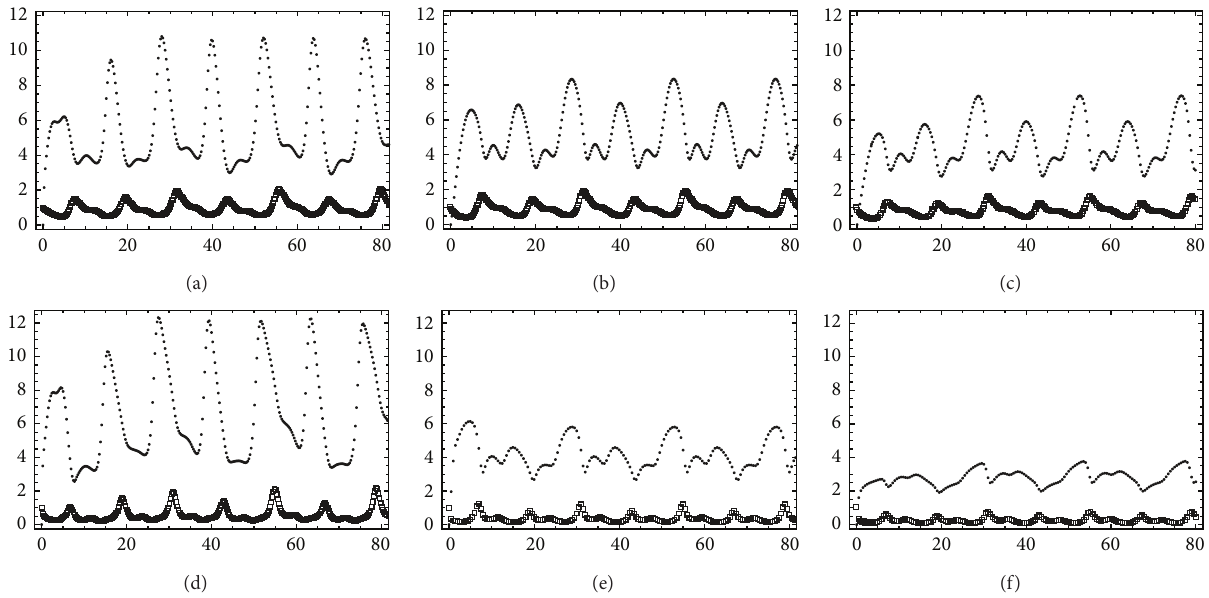
Figure 5: The effects of delays on the behavior of solutions: (1) 𝐴 = 0.4 , 𝐵 = 0.98 , and 𝑟 = 0.5 (a–c) and (2) 𝐴 = 1 , 𝐵 = 2.4 , and 𝑟 = 2.5 (d–f) with initial data of 𝑦 0 = 0 , 𝑥 0 (𝜃) = cos (𝜋𝜃/10)